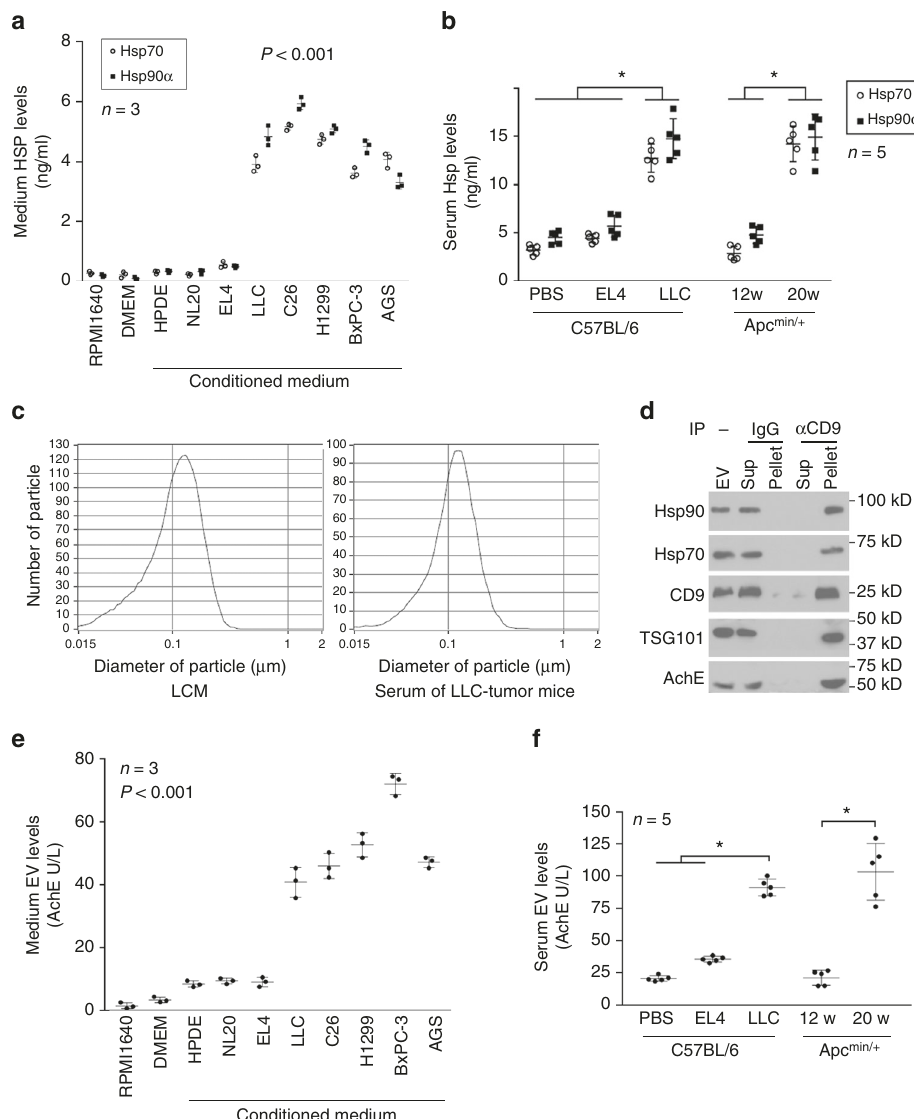
Fig. 1 Cancer cachexia co-exists with high circulating levels of Hsp70 and Hsp90 associated with tumor cell-released EVs. a Cachexia-inducing tumor cells constitutively release high levels of Hsp70 and Hsp90. Hsp70 and Hsp90 content in conditioned media of cachexia-inducing tumor cells (LLC, C26, H1299, BxPC3 and AGS) are compared with that of non-cachexia-inducing tumor cell EL4 and non-tumorigenic cells (NL20, HPDC and C2C12 myotubes). All cells were incubated for 48 h in regular media (RPMI 160 or DMEM supplemented with 10% fetal bovine serum) and then analyzed for Hsp70 and Hsp90 content by ELISA. Data ( n = 3) were analyzed by analysis of variance (ANOVA). b Cachexia co-exists with elevated circulating Hsp70 and Hsp90 in tumor- bearing mice. Hsp70 and Hsp90 levels in the sera of PBS-injected control, EL4 tumor- or LLC tumor-bearing C57BL/6 mice on day 21 of tumor implant, and Apc min/+ mice that were pre-cachectic (12 weeks of age) or cachectic (20 weeks of age) were determined by ELISA. Data ( n = 5) were analyzed by ANOVA (for C57BL/6 mice) or Student t -test (for Apc min/+ mice). * denotes a difference among bracketed C57BL/6 mice or with pre-cachectic Apc min/+ mice ( P < 0.05). c Particle size of EVs isolated from LCM and the serum of cachectic LLC tumor-bearing mice were analyzed using ZetaView® Nanoparticle Tracking Analyzer. d Tumor-released Hsp70 and Hsp90 are associated with CD9/TSG101/AchE-positive EVs. EVs were isolated from LCM and subjected to immunoprecipitation using CD9 antibody with pre-immune IgG as control. EVs, precipitated pellet and supernatant were analyzed with western blotting. e Cachexia-inducing tumor cells constitutively release high levels of EVs. EVs were isolated from diverse tumor cell-conditioned media and quanti fi ed by AchE activity. Data ( n = 3) were analyzed by ANOVA. f Cachexia is associated with elevated circulating EVs in tumor-bearing mice. EV levels in serum of indicated mice were determined. Data ( n = 5) were analyzed by ANOVA (for C57BL/6 mice) or Student t -test (for Apc min/+ mice). * denotes a difference among bracketed C57BL/6 mice or pre-cachectic Apc min/+ mice ( P <